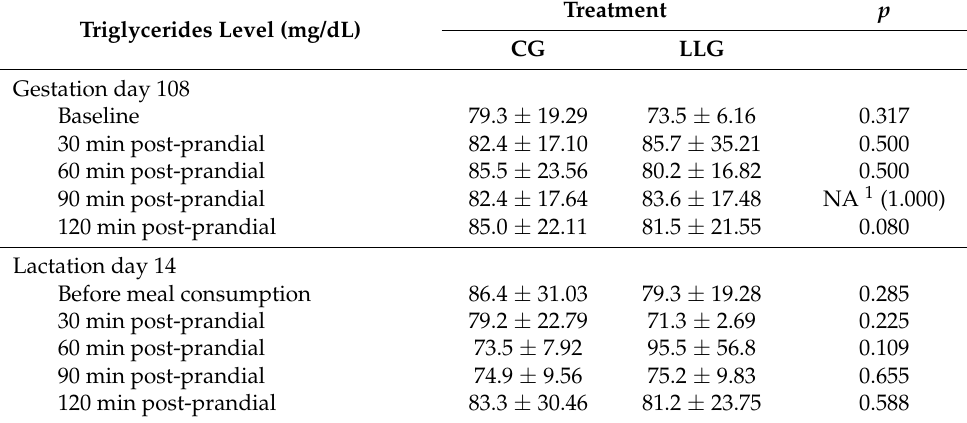
Table 5. Average blood triglycerides level (mg/dL) of sows before and 30, 60, 90 and 120 min after the consumption of morning meal, according to treatment ( n = 15 per treatment).